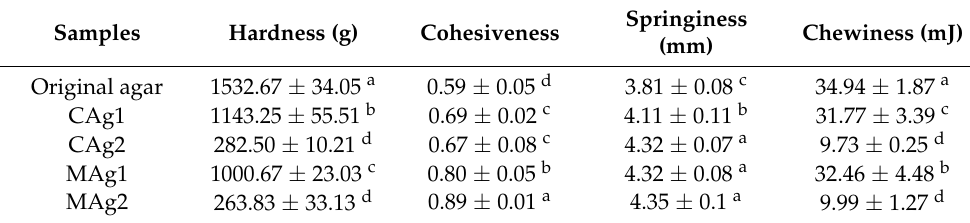
Table 3. Effect of the synthetic method on the textural properties of carboxymethyl agar. Samples Hardness (g)